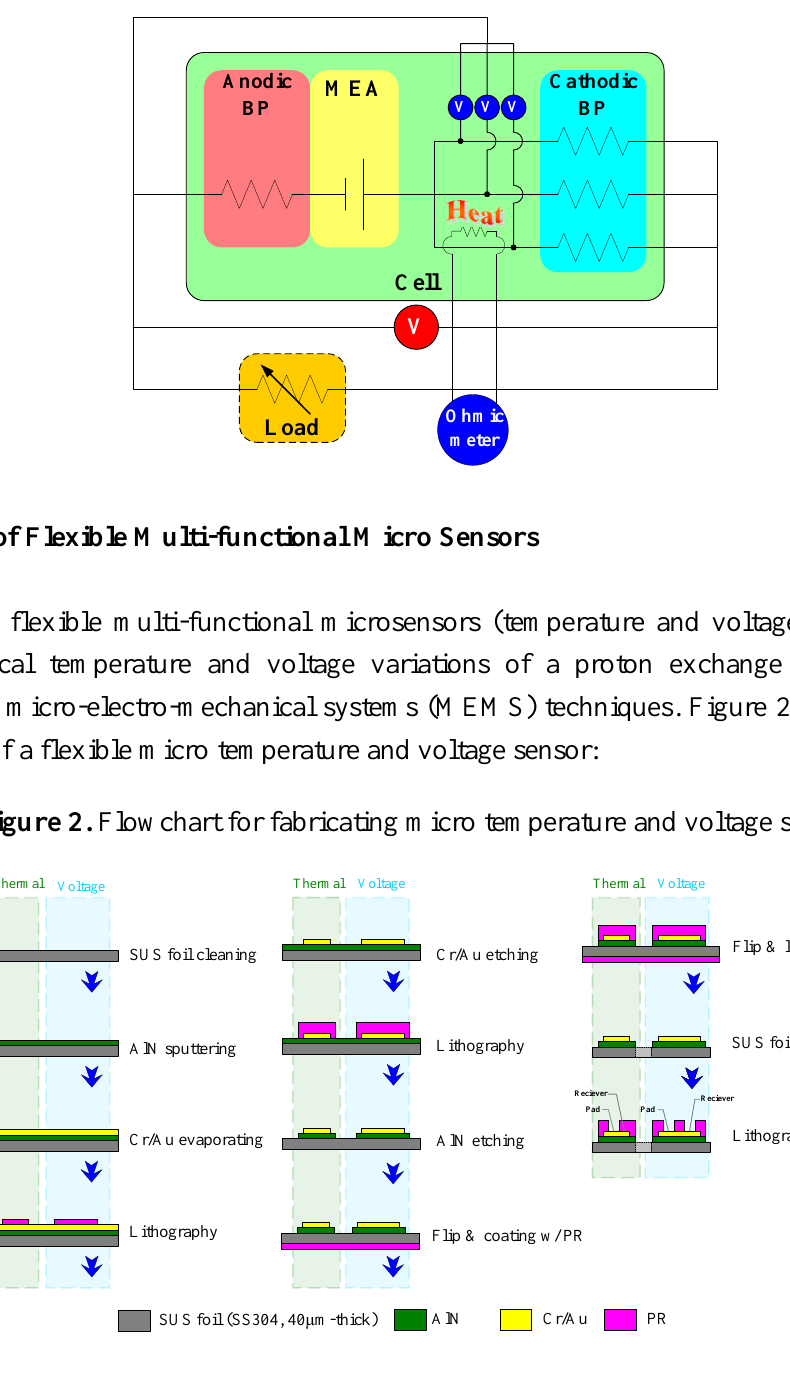
Figure 1. Schematic of the temperature and voltage measurement system.